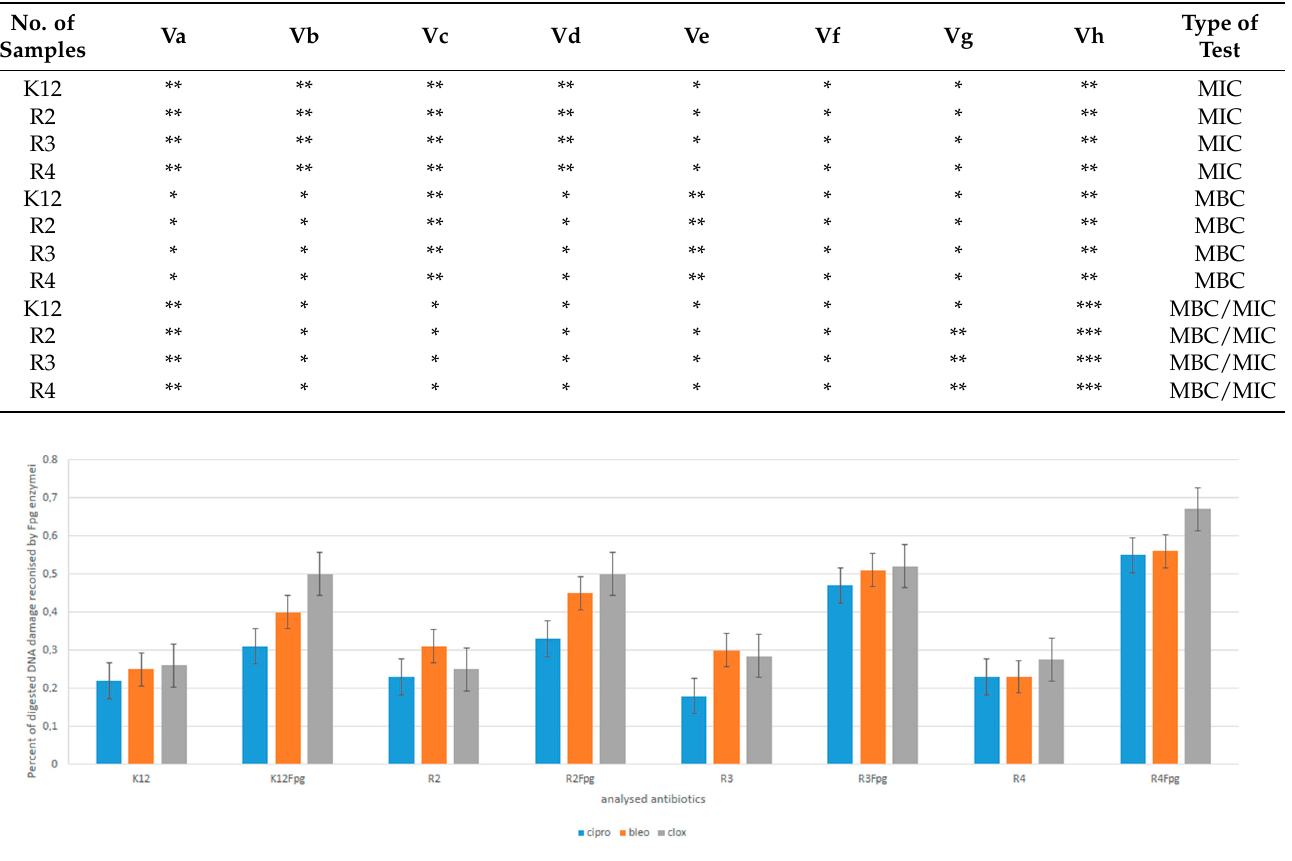
Figure 8. Percentage of bacterial DNA recognized by Fpg enzyme in model bacterial strains after ciprofloxacin, bleomycin, and cloxacillin treatment. The compounds were statistically significant at p < 0.05. (See Supplementary Materials Figure S3).